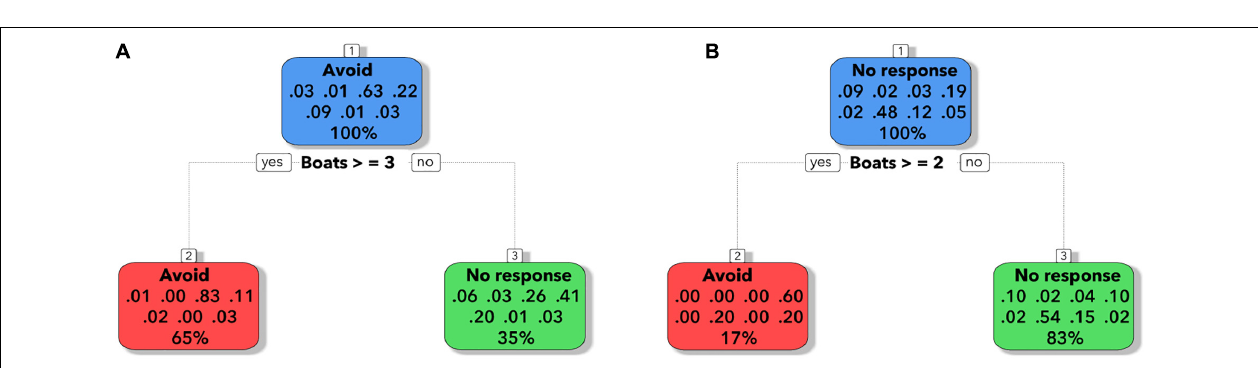
FIGURE 5 | Individual response to the vessels for the morning (AM) and afternoon (PM) (A) . Frequency of an individual response to vessel disturbance for the dolphins. Individual responses for the Chañaral de Aceituno (CDA) and Punta de Choros (PDC) cove in T2 (B) .